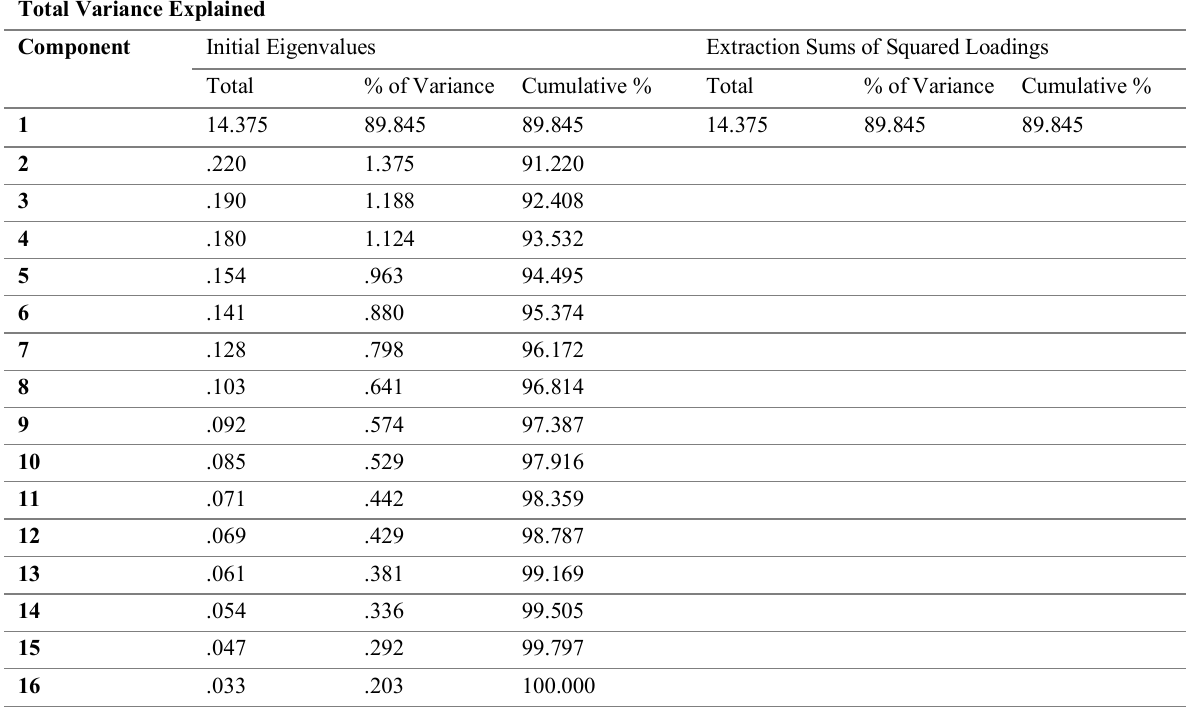
Table 3: Total variance explained for continuous quality